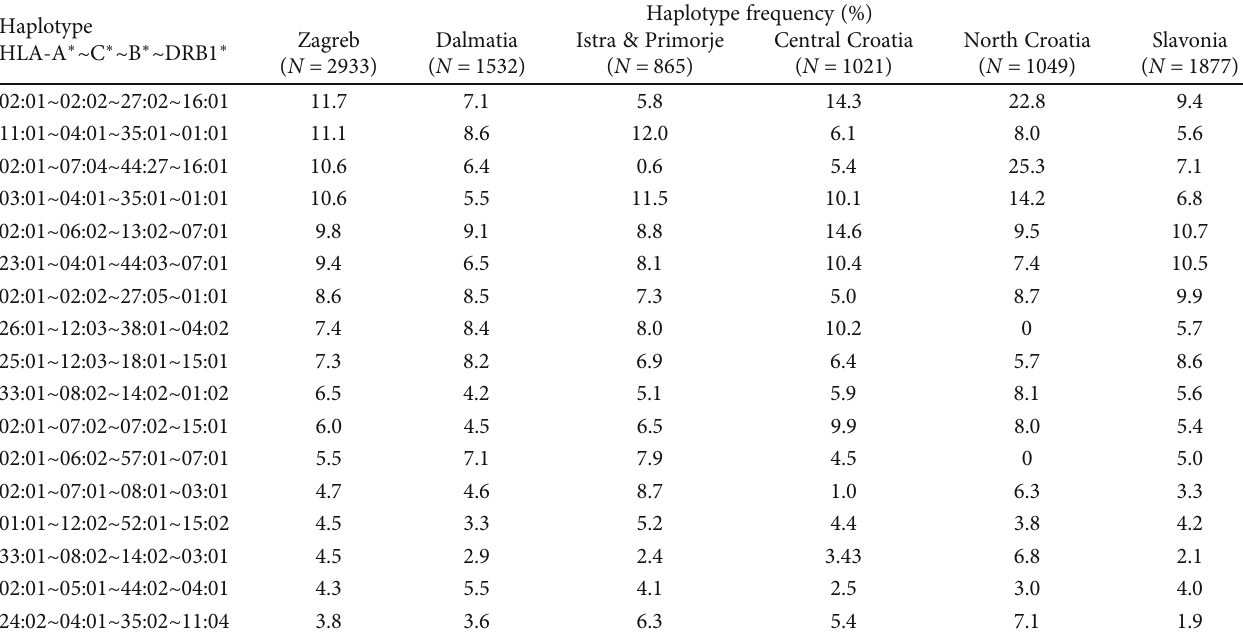
Table 3: The distribution of the twenty most frequent HLA-A ~ C ~ B ~ DRB1 haplotypes in Zagreb and fi ve di ff erent regions of Croatia (three most frequent haplotypes are not included).